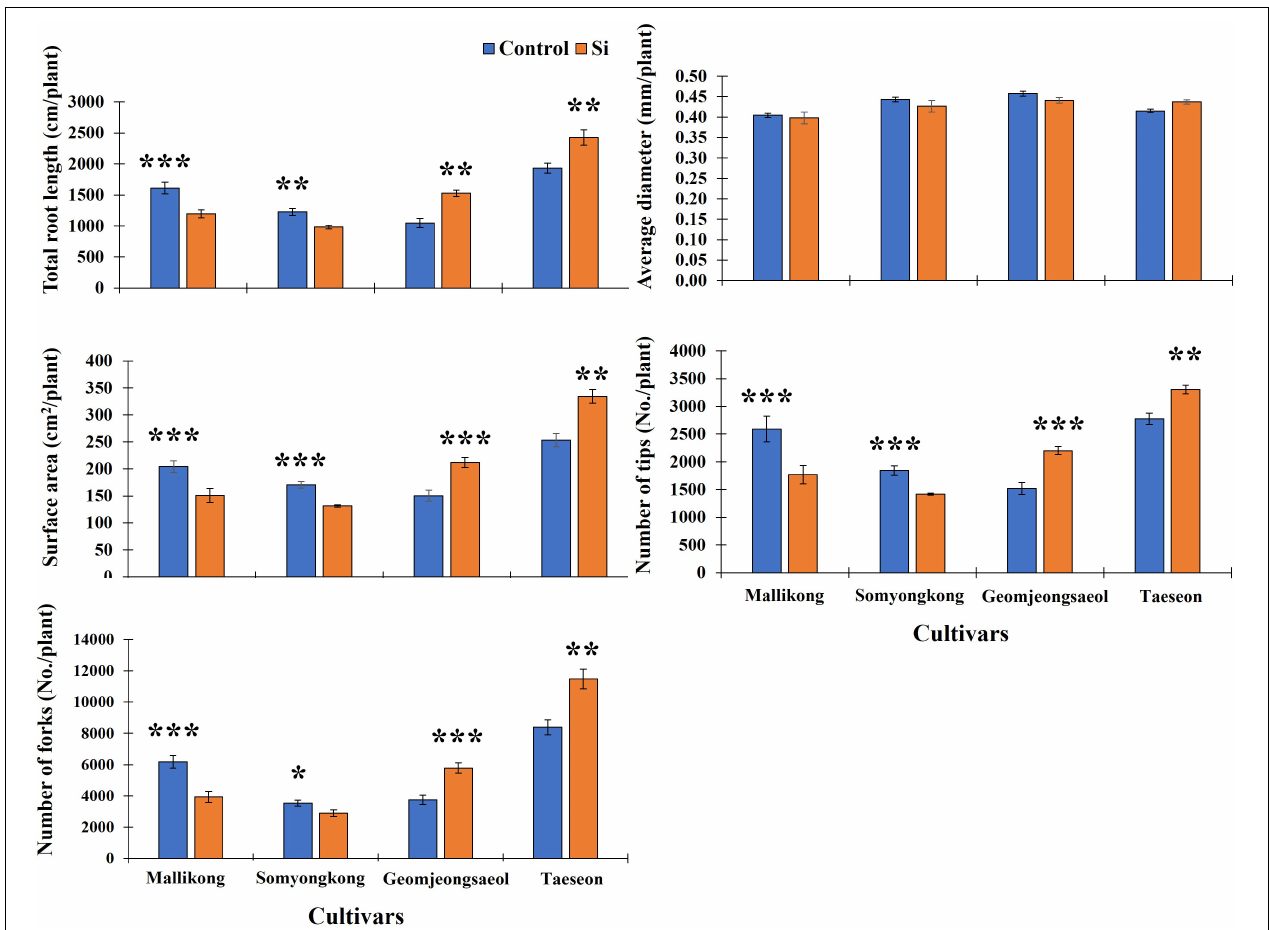
FIGURE 5 | Silicon effect on root morphological and architectural traits in selected soybean cultivars. All data were collected in 7 days after Si treatment. In the figure, each blue and orange bar represents control and Si treatment, respectively, and the vertical bar with error bars indicate average ± standard error ( n = 5 ). The experiment was conducted by five replications. In the figure, asterisks indicate significant difference by Student’s t -test (*0.01 < P < 0.05; **0.001 < P < 0.01; *** P <